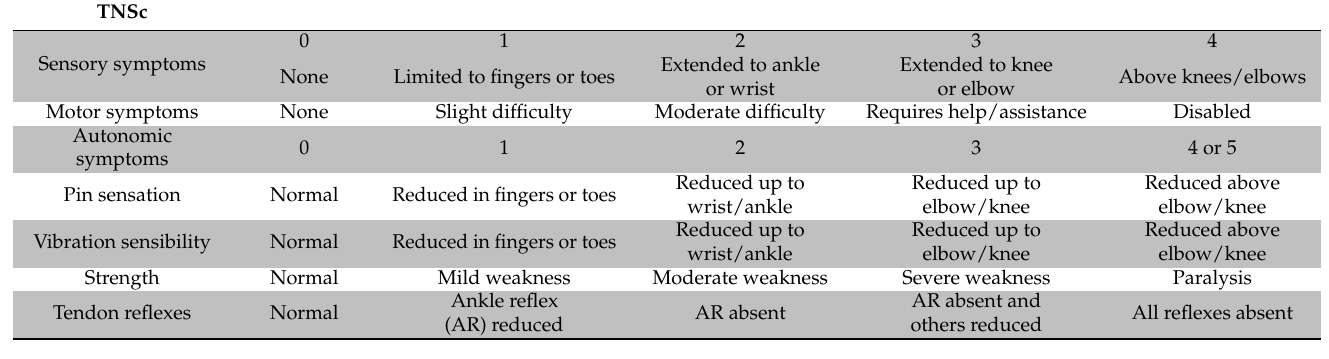
Table 2. Total Neuropathy Score—clinical criteria.